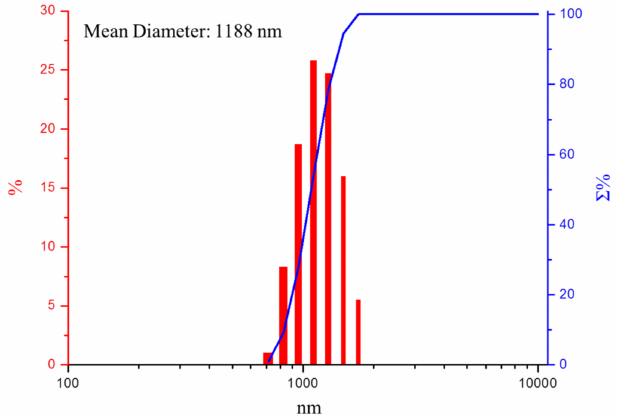
Figure 4. Particle size distribution (red column) and accumulation (blue line) pattern of the FMMT- AAm-NaF